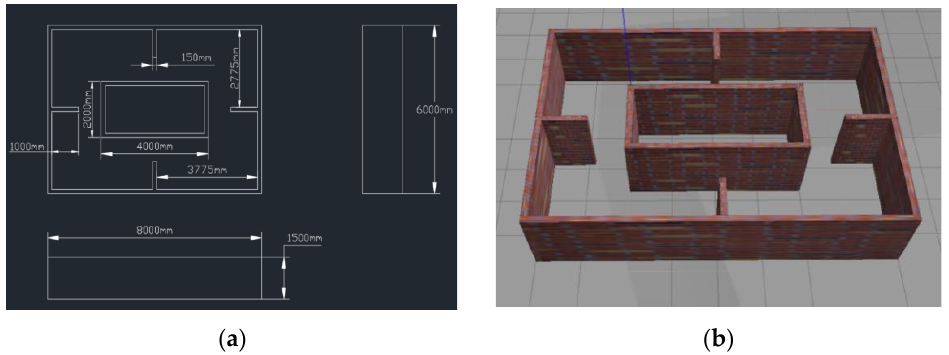
Figure 16. ( a ) Two-dimensional map of simulation map. ( b ) Virtual simulation 3D map.